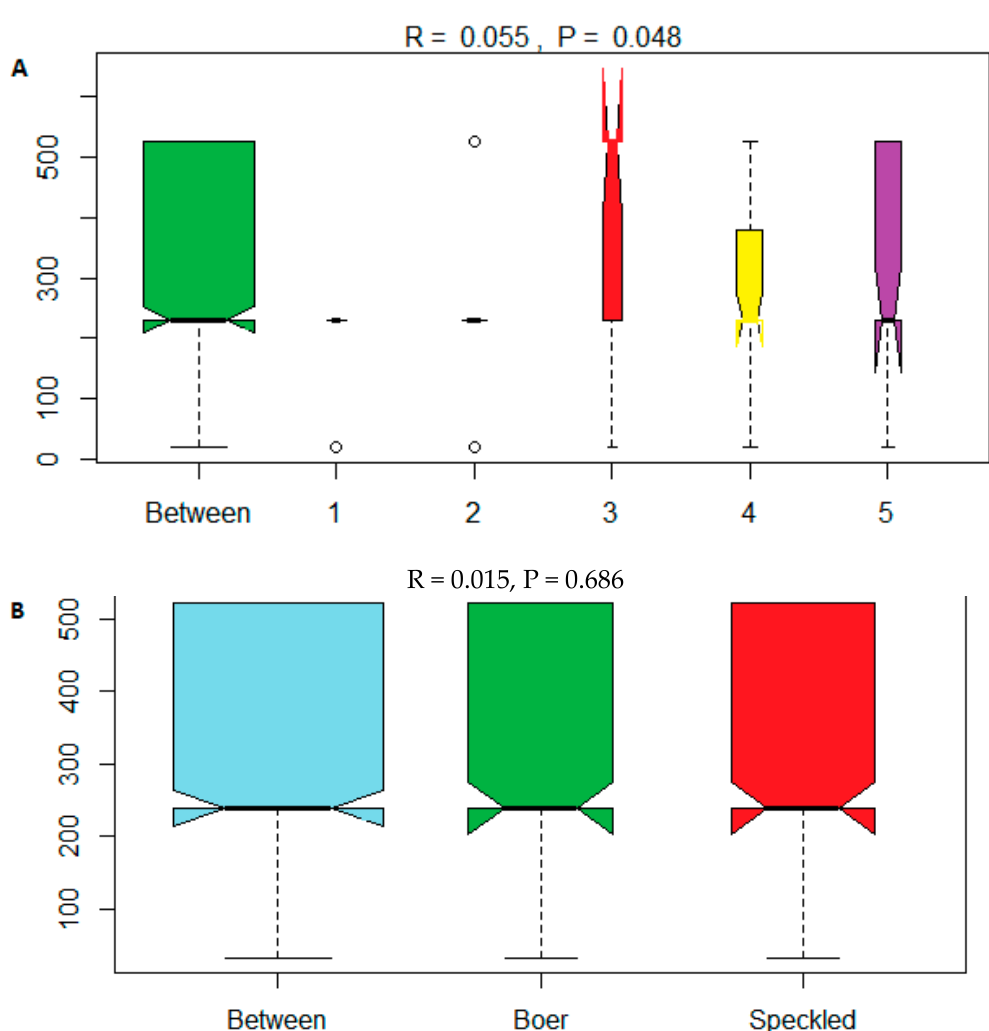
Figure 7. Adonis plots showing similarities between treatments. Analysis of similarities (ANOSIM) of the differences in structure of bacterial community in rumen of goats between treatments ( A ) 1 = (Treatment 1); 2 = (Treatment 2); 3 = (Treatment 3, red); 4 = (Treatment 4, orange); 5 = (Treatment 5, purple). The difference in structure of bacterial community between Boer and Speckled goats were also shown ( B ). Y axis shows the ranks of dissimilarity. The ends of the whiskers represent the minimum and maximum of all the data within the group. “Between” represents the difference between the five treatment groups, the closer the R-value is to 1, the greater the difference between the breeds and treatment.